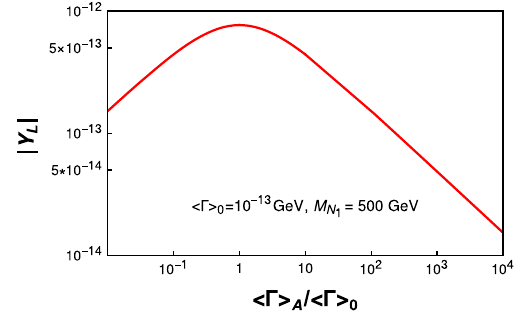
Fig. 1 The dependence of the lepton asymmetry Y L (scaled by Y 0 as a function of the ratio of CP-conserving and violating decay widths,